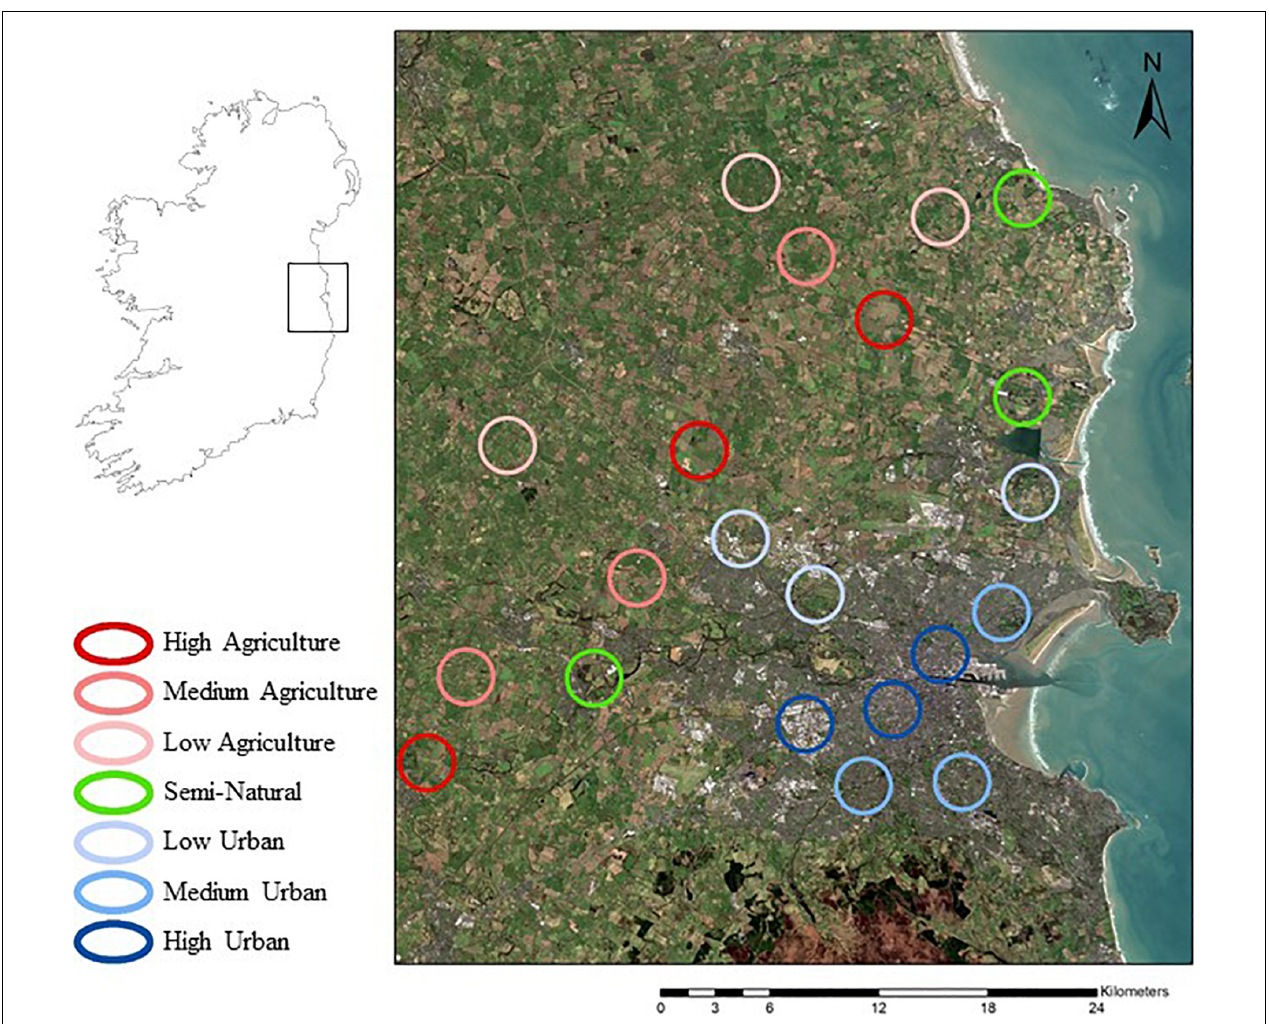
FIGURE 1 | Location of the 21 sites. The nine urban sites are in Dublin city. The nine agricultural sites are in the surrounding agricultural landscape in counties Dublin, Kildare, and Meath and the three semi natural sites are in landscapes with a higher proportion of semi natural